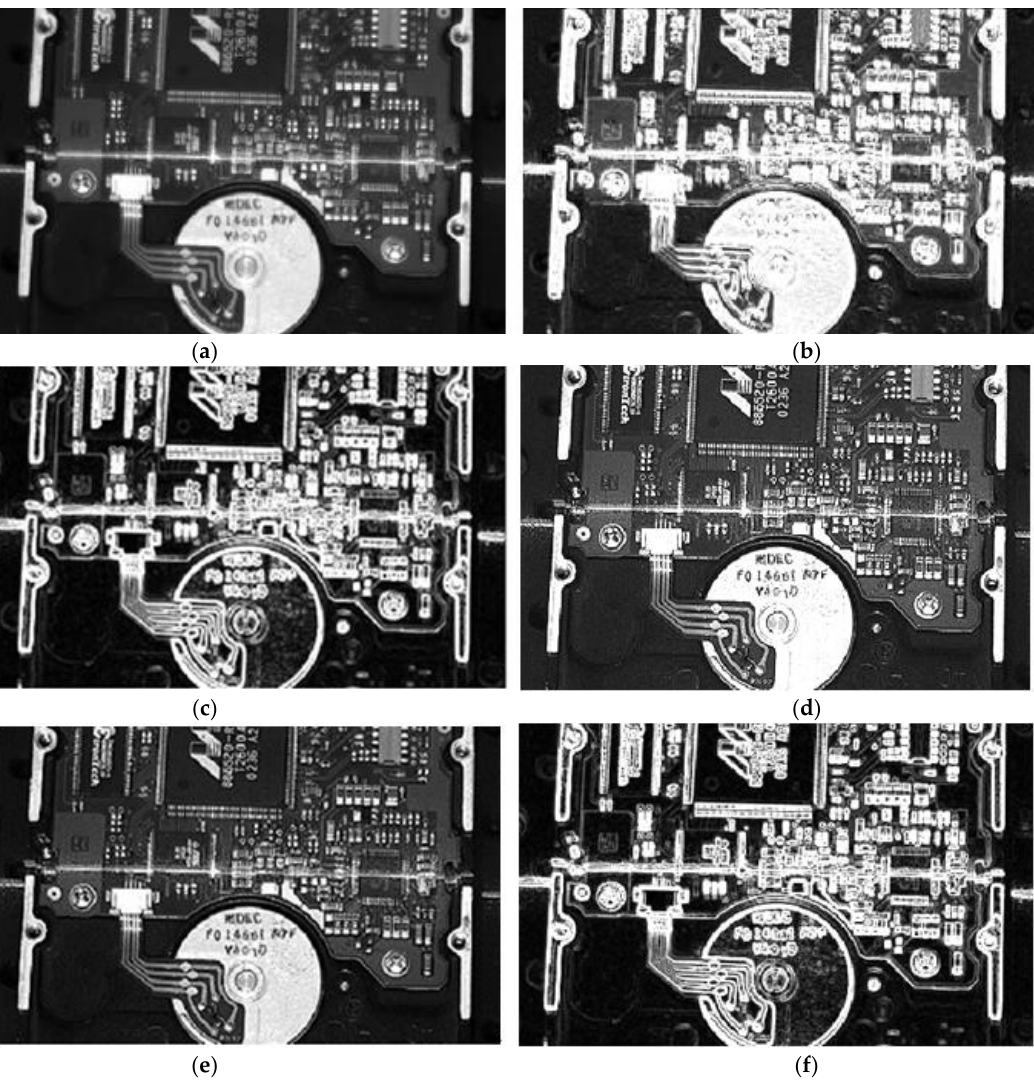
Figure 6. Image enhancement effect of the PCB board with solder joint: ( a ) original drawing of PCB board with solder joint; ( b ) Laplacian enhancement; ( c ) Sobel enhancement; ( d ) v = 0.5 differential enhancement; ( e ) v = 0.7 differential enhancement; ( f ) v = 0.8 differential